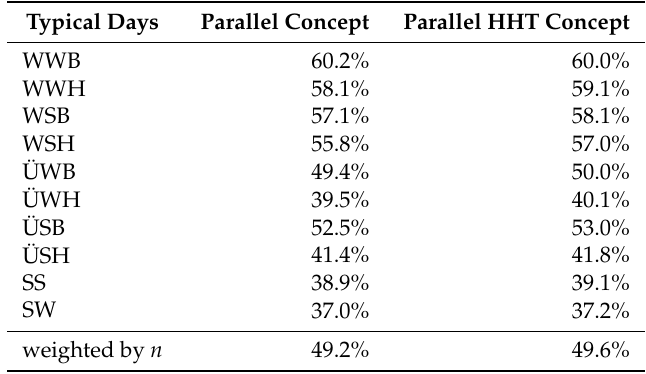
Table 6. Exergetic efficiency per typical day for parallel and parallel-HHT heat